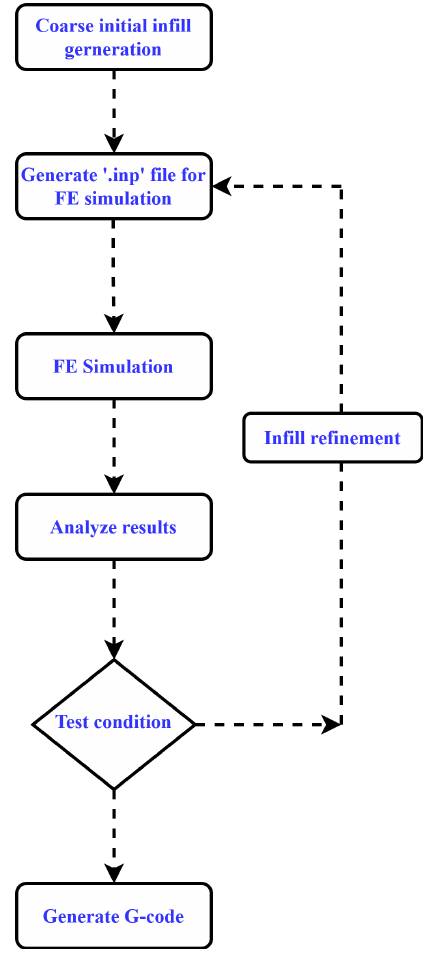
Figure 2. Iterative loop for the refinement